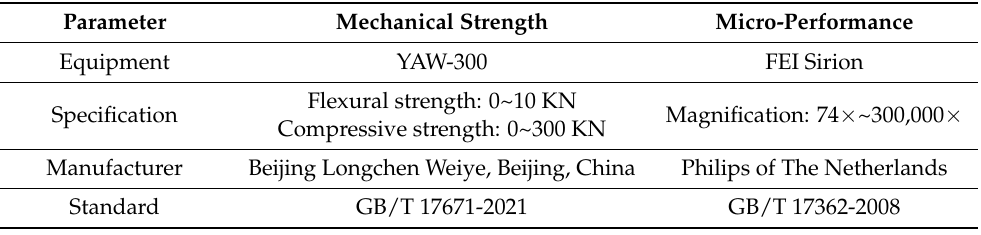
Table 3. The test device specifications and standards corresponding to different